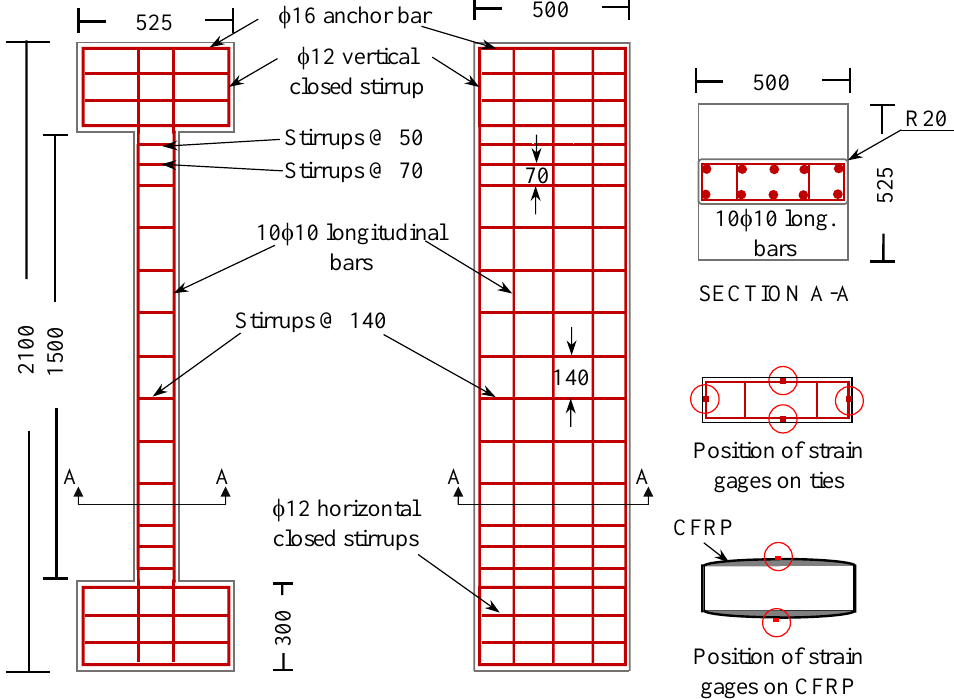
Figure 1. Details of column specimen (all dimensions are in mm).